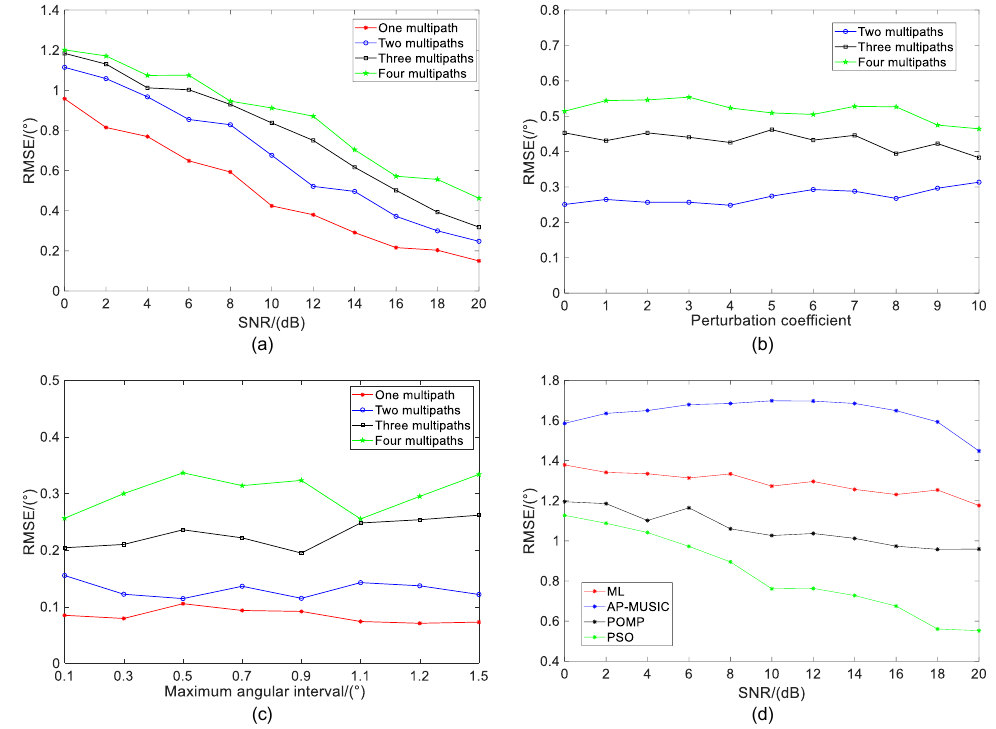
Figure 6. The proposed algorithm RMSE results in complex terrain condition. ( a ) The RMSE of the proposed algorithm under different SNRs at a given angle interval. ( b ) The RMSE of the proposed algorithm RMSE under different perturbation values at a given SNR of 20 dB. ( c ) The RMSE of the proposed algorithm under different angle intervals at a given SNR of 20 dB and perturbation value of 1. ( d ) The RMSE results of different algorithms under different